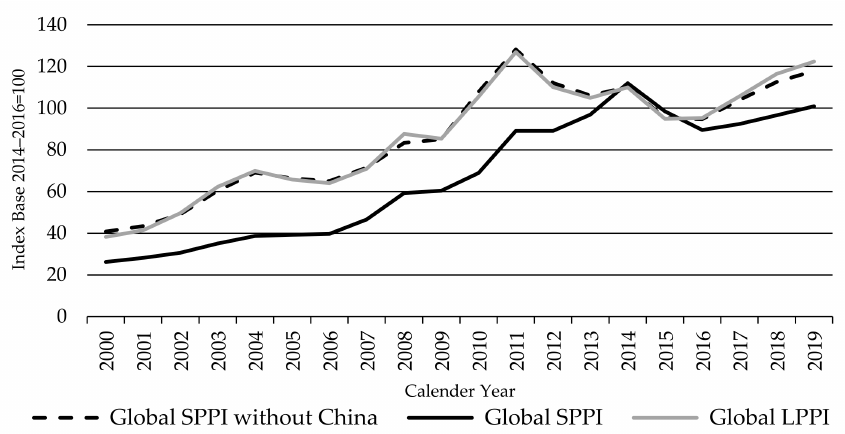
Figure 13. The Global Sheep Meat Producer Price Index SPPI without China, in comparison with the Global Sheep Meat Producer Price Index SPPI and the Global Lambs Producer Price Index LPPI, source: own